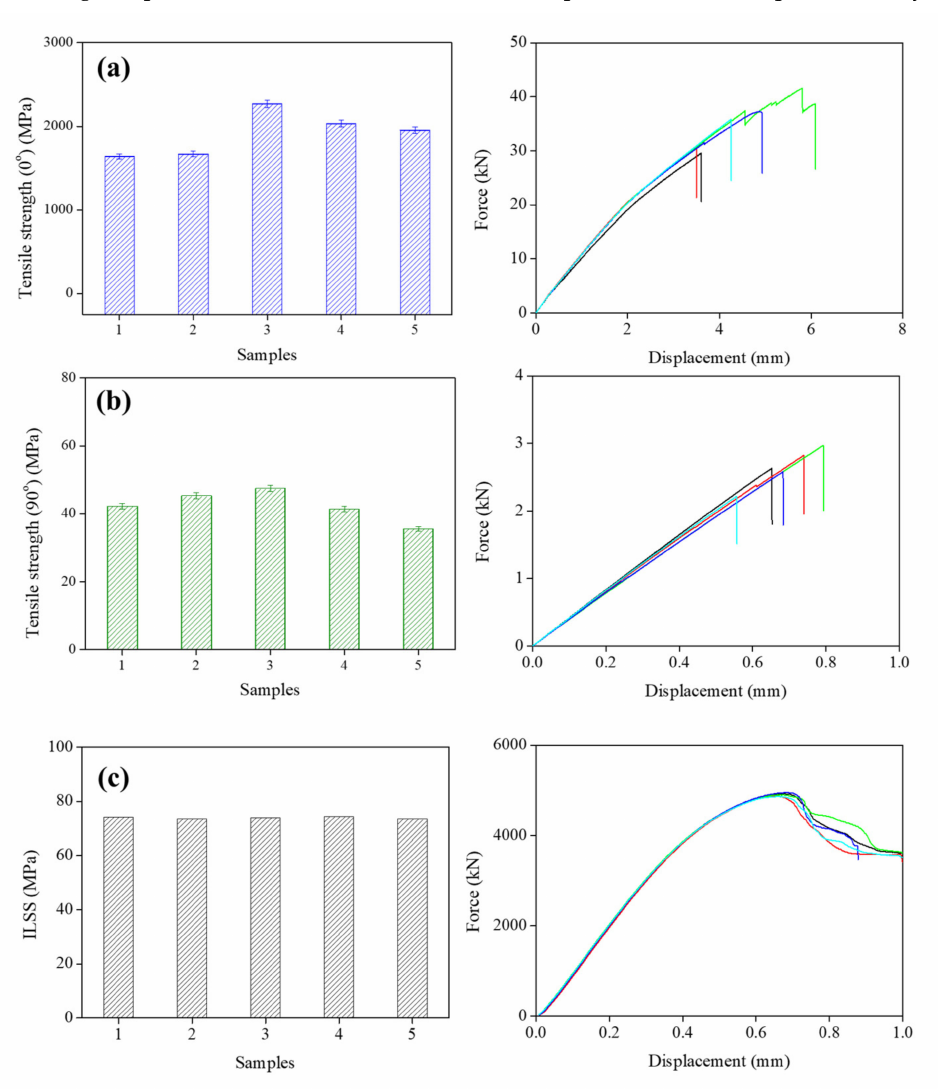
Figure 9. ( a ) Tensile strength (0 ◦ ), ( b ) tensile strength (90 ◦ ), and ( c ) ILSS of the CF/PPS composites (processing temperatures of 280 ◦